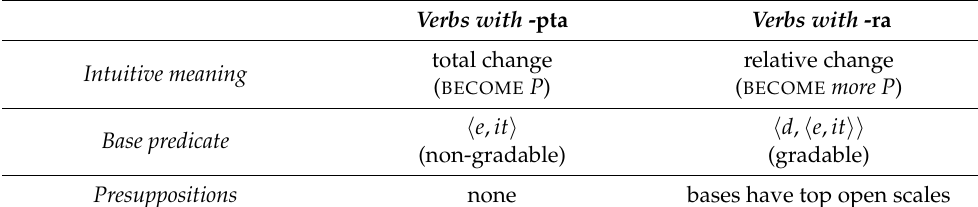
Table 1. Interim